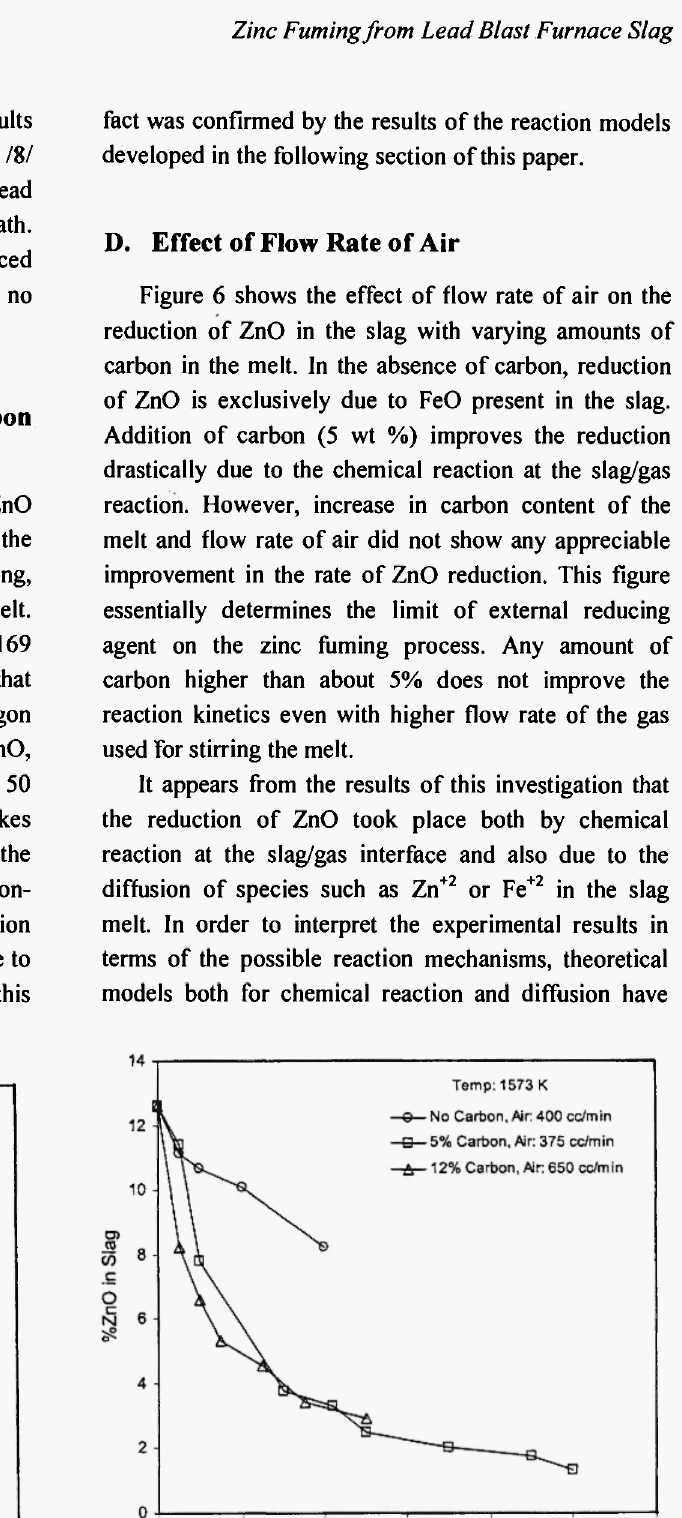
Fig. 6: Effect of flow rate of air on ZnO reduction at 1573 Κ with varying amounts of carbon in the